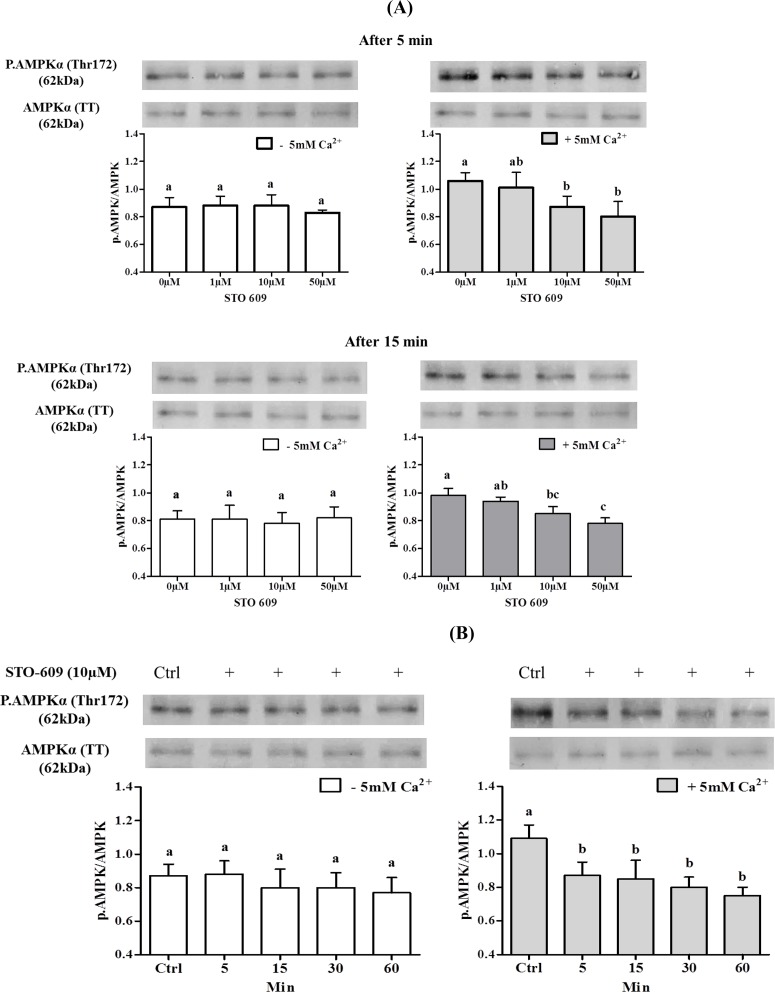
Effects of CaMKKs (STO-609) inhibitor on the AMPK phosphorylation in chicken sperm.Sperm were incubated at 35°C in the –5mM Ca2+ or +5mM Ca2+ medium with or without CaMKKs inhibitor STO-609 (1; 10; 50 μM) for 5 min and 15 min. Proteins from sperm lysates were analyzed by western-blotting using anti-phospho-Thr172-AMPKα or anti-AMPKα as primary antibody. Bands for phospho-Thr172-AMPKα were detected at 62kDa (top lanes). Total AMPKα (62kDa) was used as loading control (bottom lanes) and the phosphorylated protein AMPKα (Thr172)/total AMPKα ratio is shown at the bottom. A) Effects of different concentrations of STO-609 on the AMPK phosphorylation in sperm incubated for 5 min or 15 min. The control (Ctrl): sperm incubated with or without Ca2+ in the absence of STO-609. B) Effects of 10μM STO-609 on the AMPK phosphorylation in sperm incubated for 5, 15, 30, 60 min. The control (Ctrl): sperm incubated 0 min with or without Ca2+ in the absence of STO-609. Results express the mean ± SEM of the mean from 6 different experiments. Different superscripts indicate statistically significant differences (P < 0.05).